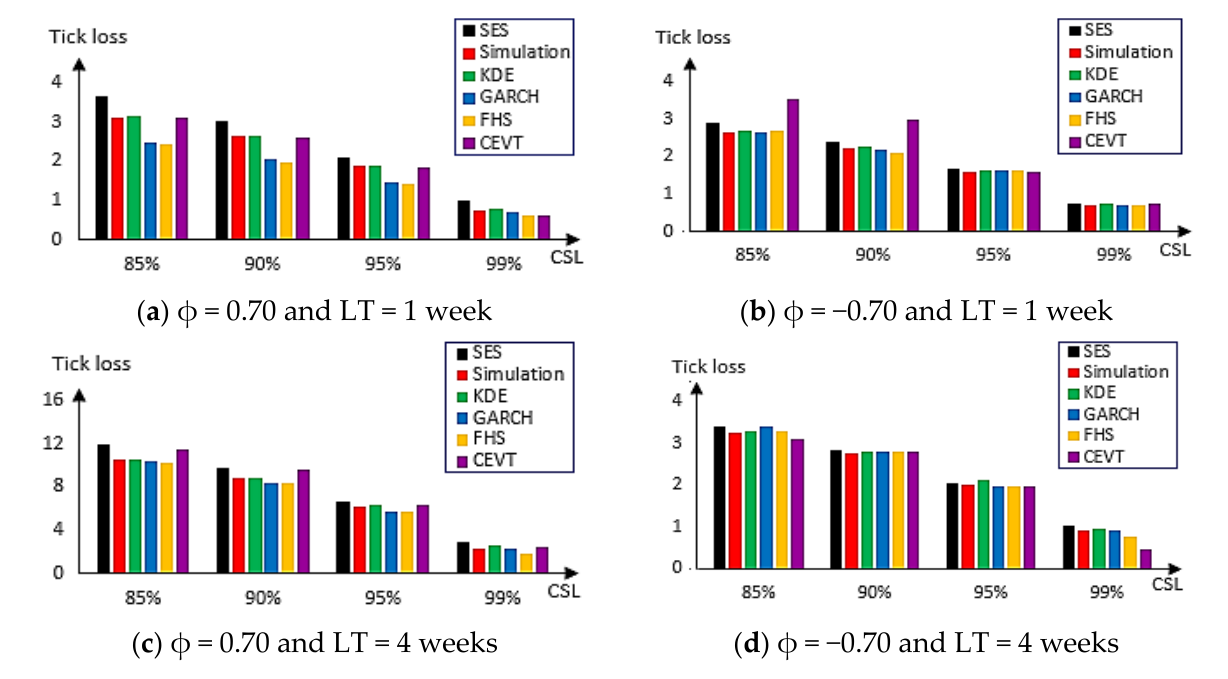
Figure 3. Tick loss function values in the case of log-normal distribution for φ = 0.70 ( a , c ) and φ = − 0.70 ( b , d ) and lead times of one week ( a , b ) and four weeks ( c , d ). Figure 3 shows the tick loss values in the case of log-normal distribution for φ = 0.70 (on the left) and φ = − 0.70 (on the right) and lead times of one week (upper panel) and four weeks (lower panel). We can remark for the four panels when the CEVT provides a higher tick loss value we find that the FHS provides the lowest loss, followed by the GARCH method and vice